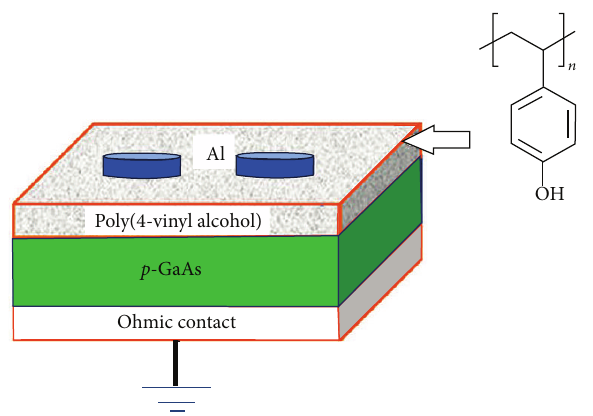
Figure1:SchematicdiagramoftheAl/poly(4-vinylphenol)/ p -GaAs